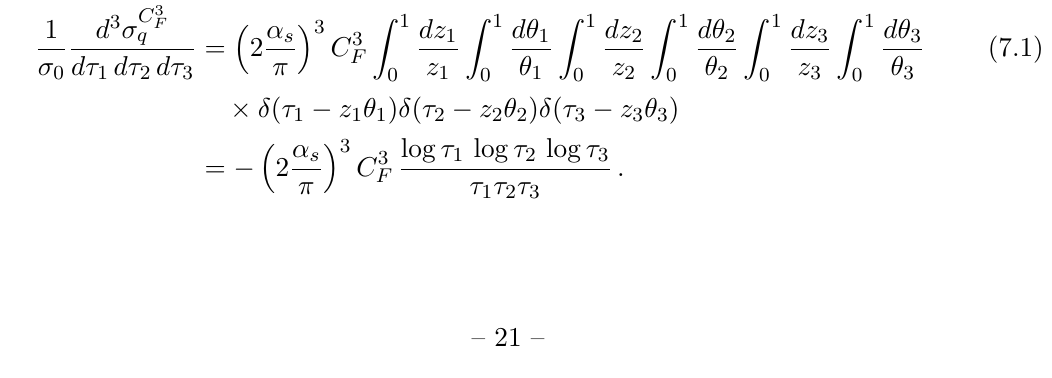
Figure 3. Results of a scan over (cid:11) of the AUC for the observable likelihood for jets on which only (cid:28) 1 is measured is the dotted line and for jets on which both (cid:28) 1 and (cid:28) 2 are measured is the dashed line, for comparison. The AUC for the observable is minimized at (cid:11) = 0 : 2 where it takes the value 0 : (cid:0)